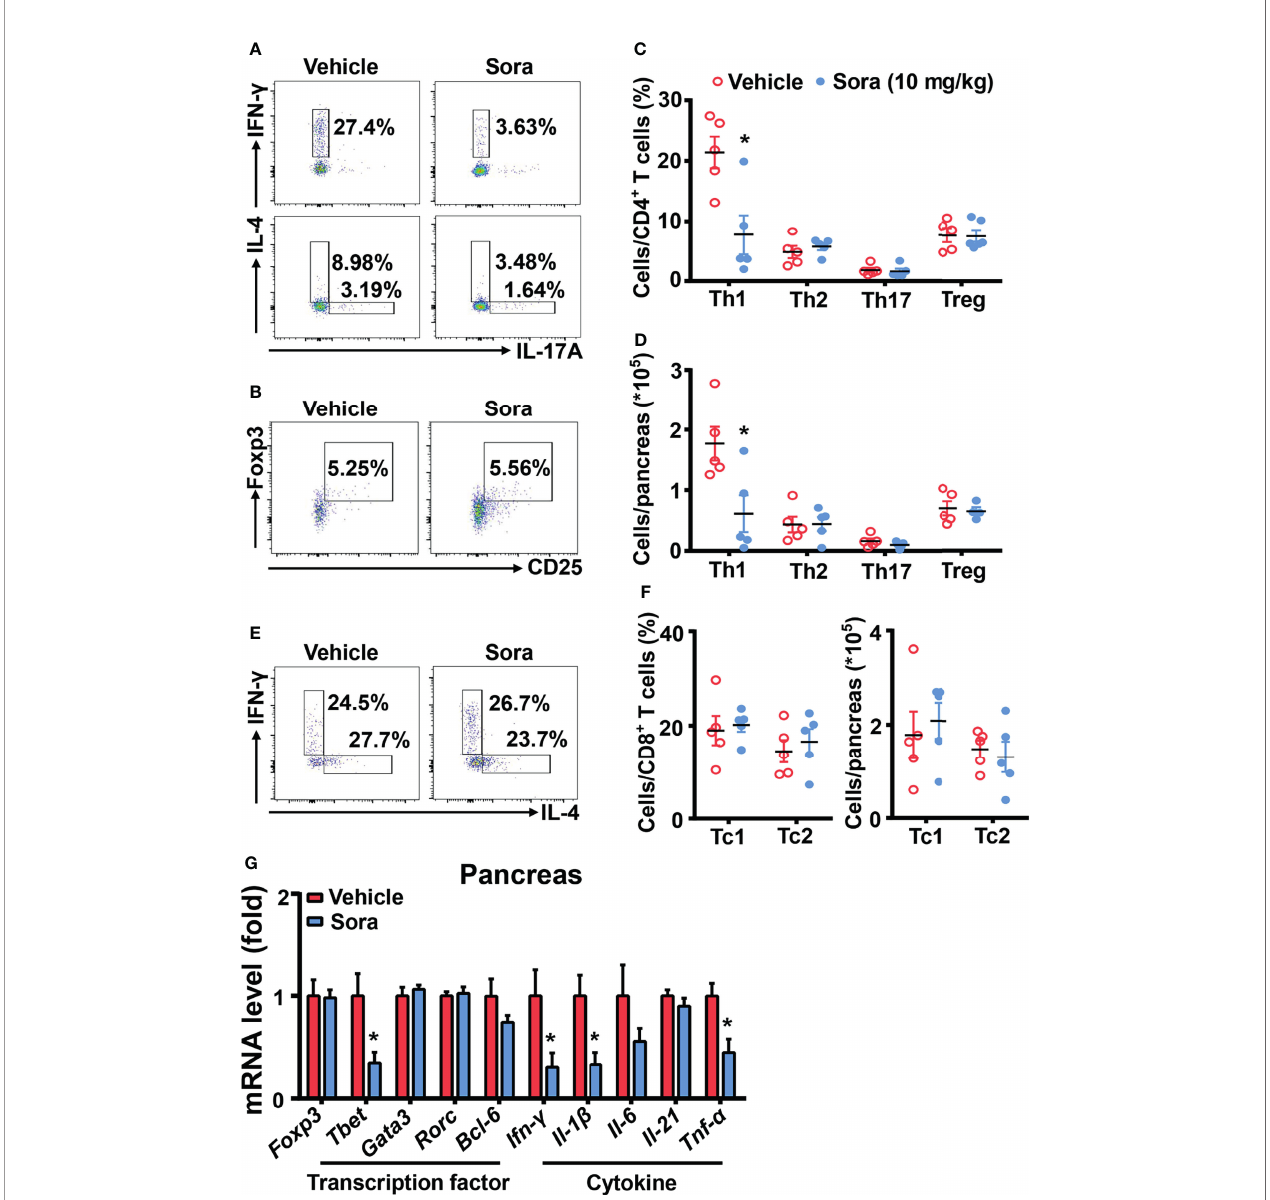
FIGURE 3 | Sorafenib decreases in fl ammatory Th1 cells in the pancreas of prediabetic NOD mice. Flow cytometry analysis of the frequency and number (A – D) of Th1, Th2, Th17 cells and Tregs in pancreas from vehicle-treated or sorafenib-treated prediabetic NOD mice. Flow cytometry analysis of the frequency and number (E, F) of Tc1 and Tc2 cells in pancreas from vehicle-treated or sorafenib-treated prediabetic NOD mice. (G) RT-PCR analysis of transcription factors (Foxp3, Tbet, Gata3, Rorc and Bcl-6) and cytokines (Ifn- g , Il-1 b , Il-6, Il-21 and Tnf- a ) in pancreas from vehicle-treated or sorafenib-treated prediabetic NOD mice. Sora, sorafenib. Data represent means ± s.e.m. and data were pooled from 2 or more independent experiments. n = 5-7 mice per group in each experiment. Statistical signi fi cance: * P < 0.05 versus vehicle by